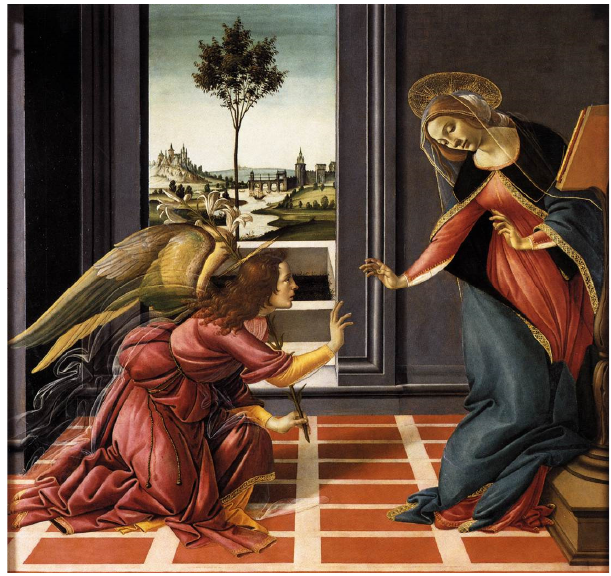
Figure 10. Sandro Botticelli, The Cestello Annunciation , 1489–1490. Galleria degli Uffizi, Florence.